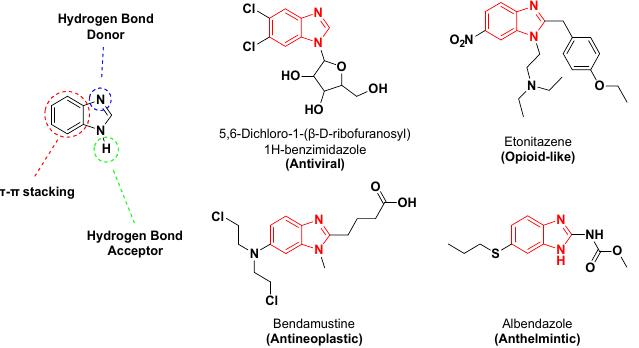
Figure 1. Benzimidazole features with common benzimidazole pharmaceutical scaffolds.